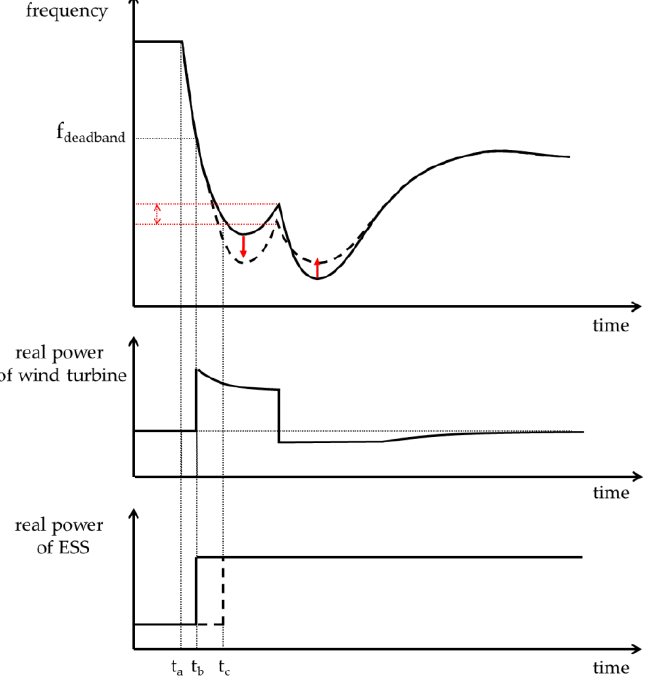
Figure 5. Concept used to improve frequency nadir.